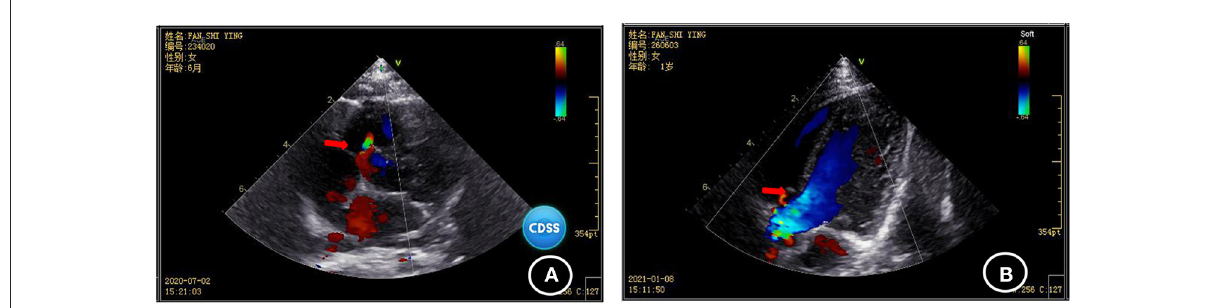
FIGURE2 Comparison of the results of two cardiac ultrasonographies of the child (A) ventricular septal defect and pseudomonal tumor formation (rupture of about 2.5mm and 1.8mm) were found in July 2020; (B) Ventricular septal defect and pseudo membrane tumor formation (1.3mm rupture) were found by heart color doppler ultrasound in January 2021.